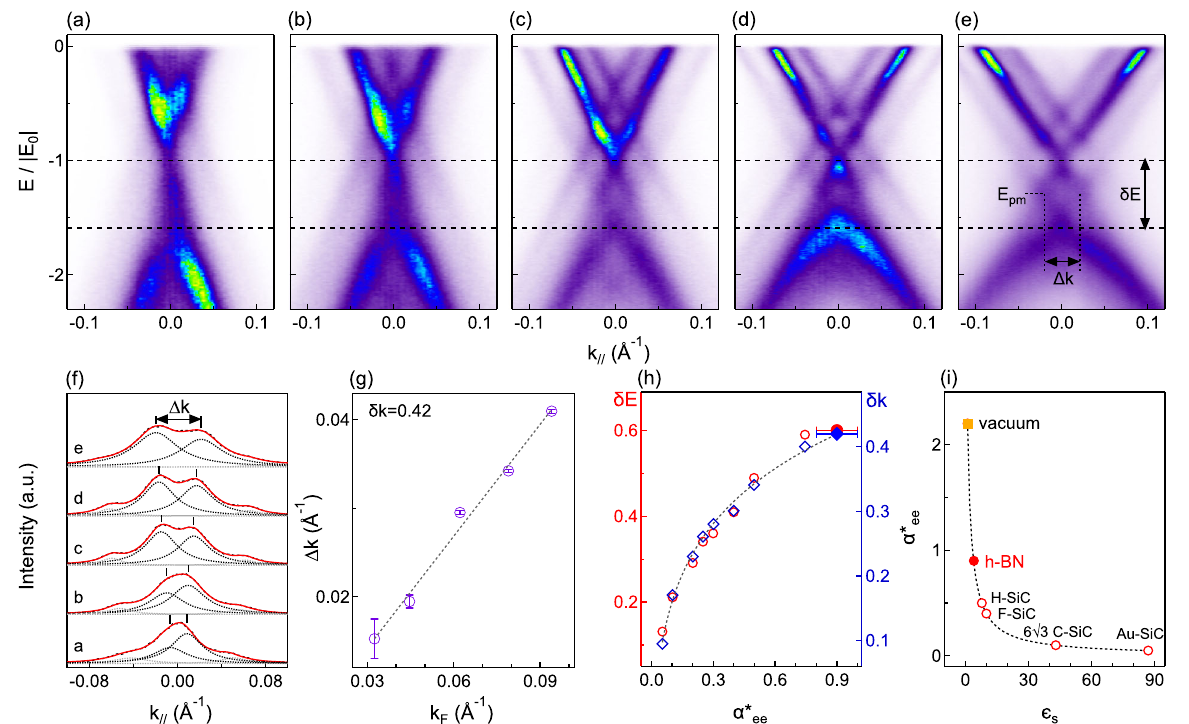
Fig. 5 The extracted effective fi ne structure constant in graphene/h-BN heterostructure. a – e Renormalized dispersions for data at high doping regime with energy scaled to ∣ E 0 ∣ . δ E represents the extracted dimensionless energy separation of the diamond shape after renormalization. f MDCs at energy of E pm for extracting the momentum separation Δ k of the diamond-shaped dispersion. g Extracted Δ k vs k F with a slope of δ k = Δ k /k F = 0.42 ± 0.02. h δ E and δ k as a function of the dimensionless constant α (cid:1) ee . Filled symbols are extracted values for our graphene/h-BN heterostructure and open symbols are from theoretical calculations 18 as a reference. The dotted curve is the fi tting curve to infer the α (cid:1) ee with larger δ E and δ k value. i Comparison of α (cid:1) ee for our graphene/h-BN sample (red fi lled symbol), reported values for other graphene systems (open symbols) 18 , and theoretical limit for graphene in vacuum (orange fi lled symbol). Black dotted curve is a plot of α (cid:1) ¼ e 2 = ϵ _ v ≈ 4.4/( ϵ + s ee F